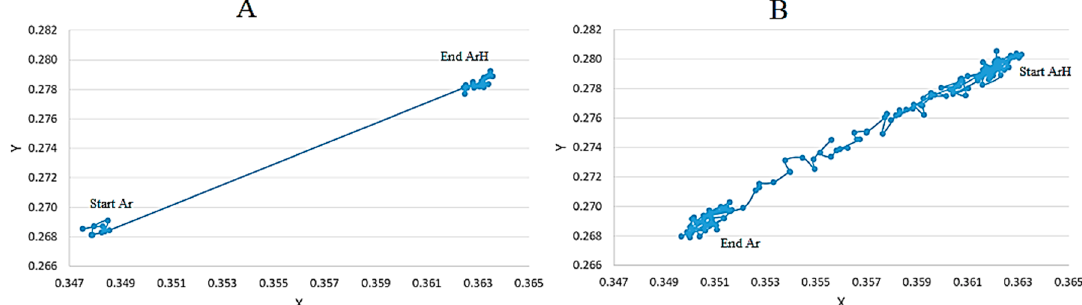
Figure 10. Switching back and forth from Ar gas to ArH gas. ( A ) Switching from Ar to ArH occurs swiftly. ( B ) Switching from ArH to Ar, the plasma colour demonstrates a colour change as the x,y values change over the course of ~1 h prior to stabilisation in a linear fashion after the target has been exposed to Argon hydrogen mixture. This observation can be interpreted as either the rate by which hydrogen is disappearing from the chamber and/or possible formation of target hydrogen compounds at the surface of the target (target poisoning by hydrogen) and the time that is required for the target to revert back its original state while switching from Ar to ArH does not demonstrate any pattern, rather a swift instant jump is observed.